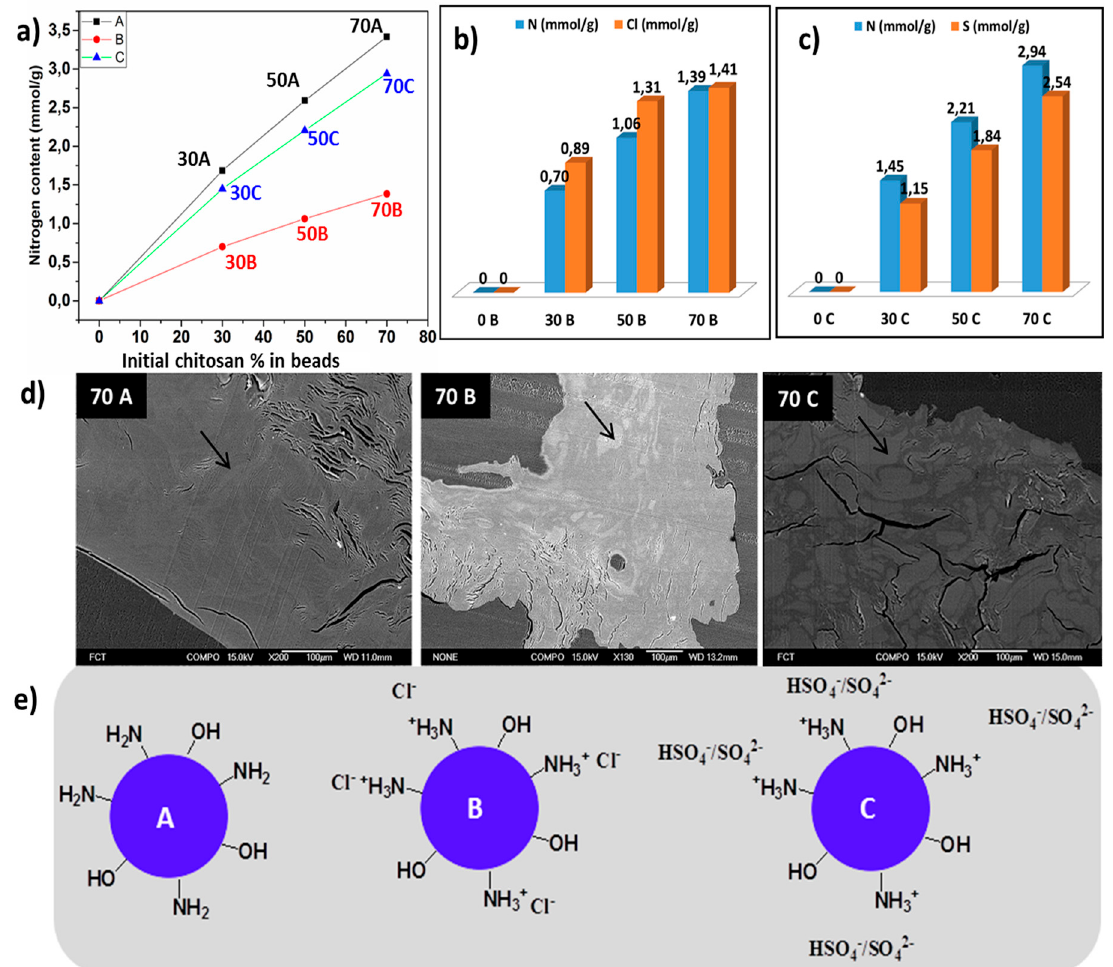
Figure 1. ( a ) Total nitrogen content present in beads with varying chitosan composition coagulated in 2 M acetic acid ( A ), 2 M hydrochloric acid ( B ) and 2 M sulfuric acid ( C ). ( b , c ) A comparison of chlorine and sulphur with the nitrogen content in B and C type. ( d ) Nitrogen element distribution measured via spot analysis in 70A , 70B , and 70C and ( e ) Presentation of possible ionic interactions in A , B and C type.